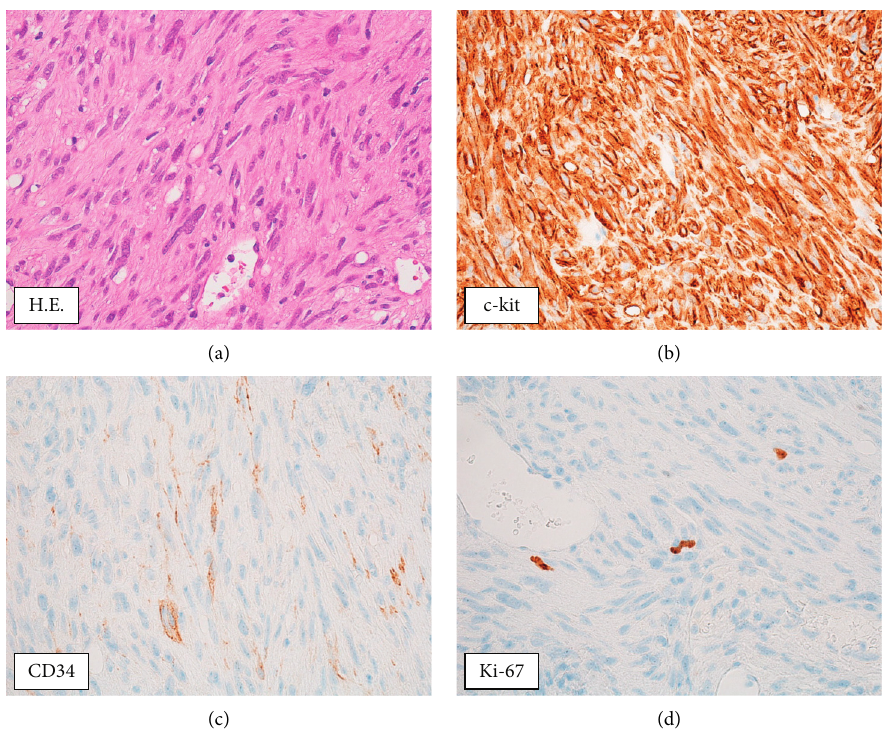
Figure 4: Pathological analysis of the liver biopsy revealed dense proliferation of spindle-shaped atypical cells. The tumor cells were positive for c-kit and CD34, and the patient was diagnosed with GIST. The MIB-1 labelling index was 2% (x